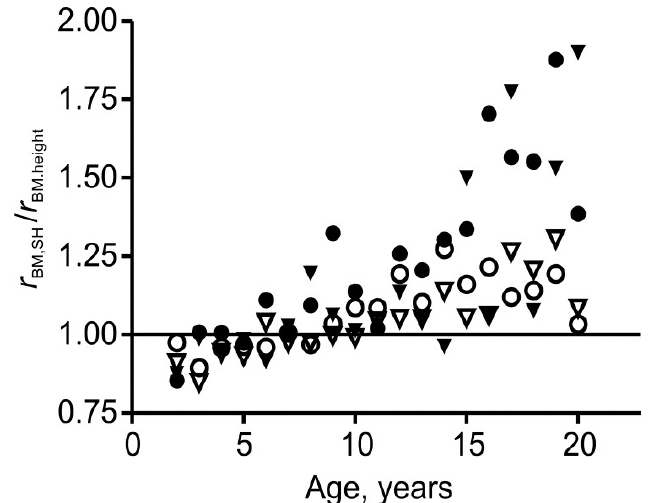
Figure 3. Comparison of sitting height and height as predictors of body mass at each age in terms of the ratio of correlation coefficients r BM.SH / r BM.height for white females ( ○ ), black females (●), white males ( ), and black males ( ▼ ).